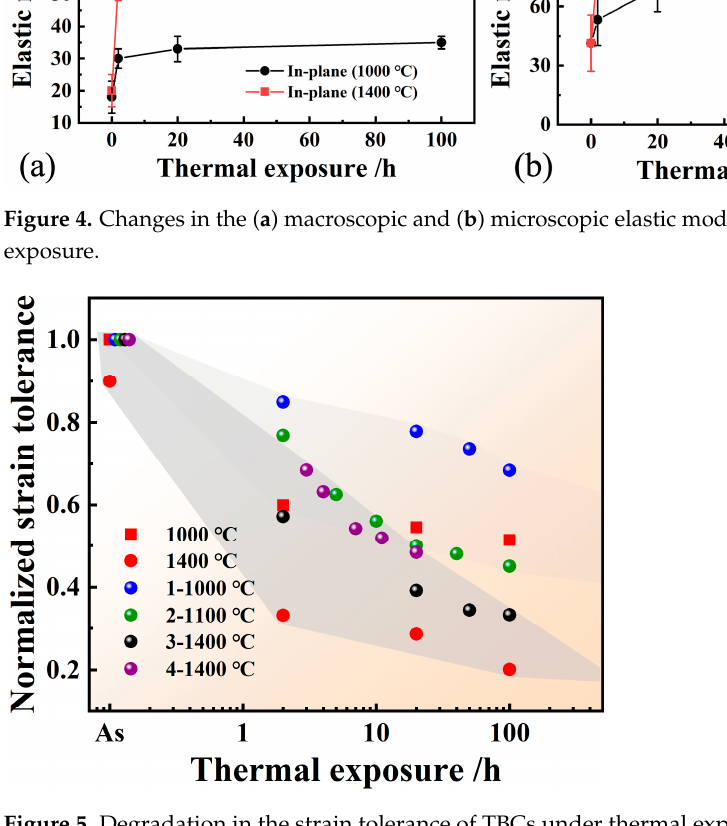
Figure 5. Degradation in the strain tolerance of TBCs under thermal exposure, 1 [29], 2 [56], 3 [57], and 4 [58].